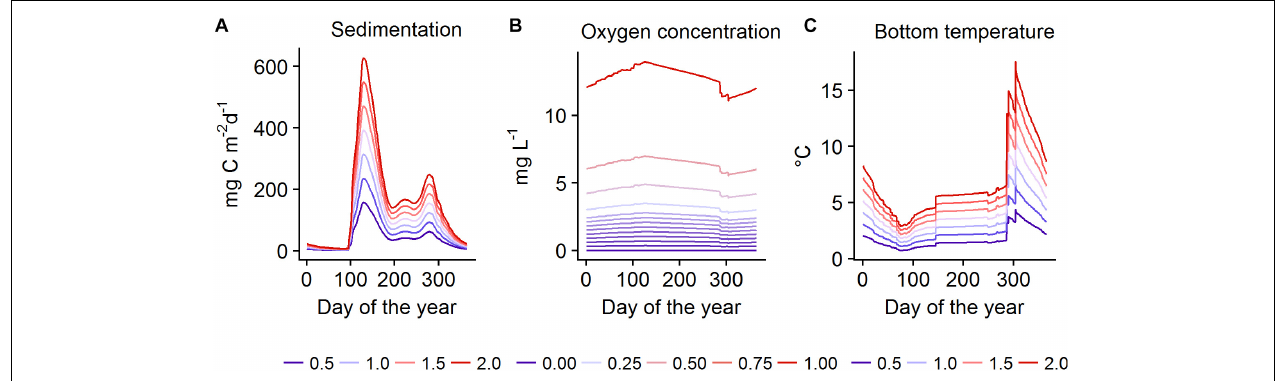
FIGURE 2 | Forcing time-series used in the BM model, showing the tested levels of sedimentation (A) , oxygen concentration (B) , and bottom temperature (C) over 1 year. Level 1 denotes the baseline.